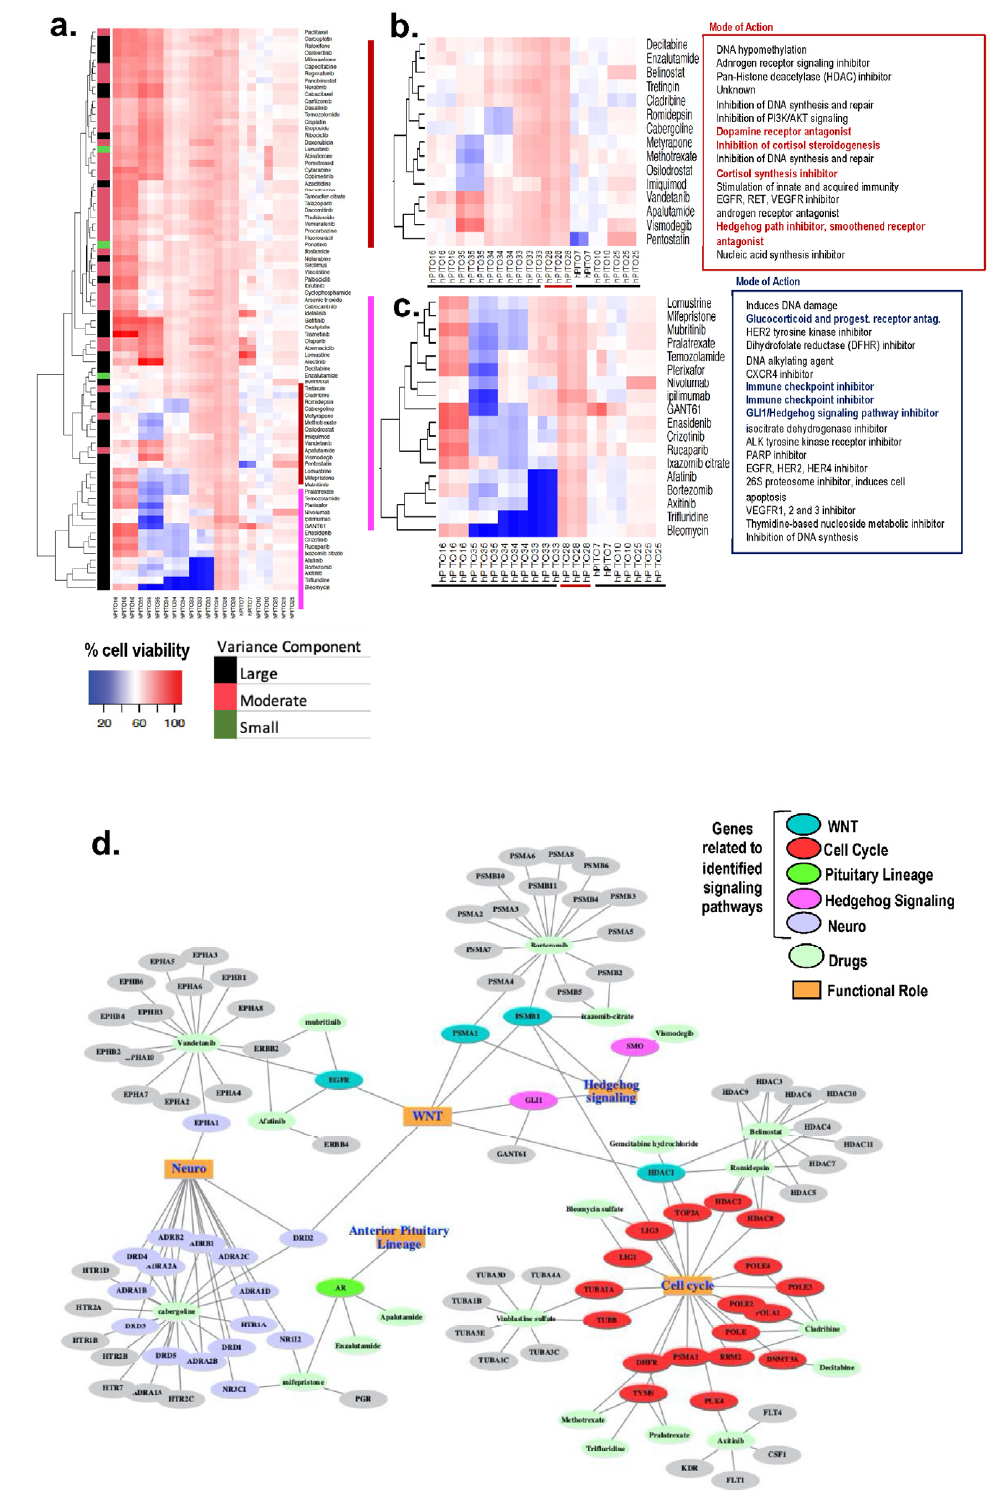
Figure 3. Drug screen using hPITOs generated from CD patients. ( a ) High-throughput drug screening of hPITOs reveals sensitivities to a range of therapeutic agents. Cell viability with high values (indicating resistance) are depicted in red, and low values (indicating sensitivity) are in blue in the clustered heatmap. ( b , c ) Clusters showing response to therapeutic agents with the most variance across the organoids. ( d ) Network of drugs from the clusters b and c and their gene targets, showing their participation in signaling pathways and cellular processes.